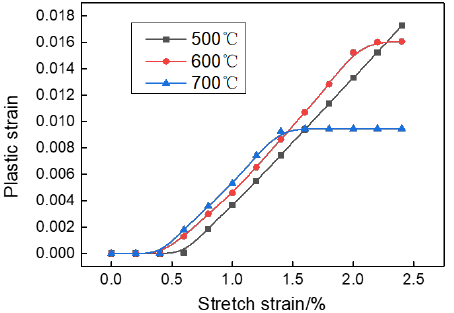
Figure 16. The relationship between plastic strain and stretch strain. The stress contours of the profile under different holding time are presented in Figure